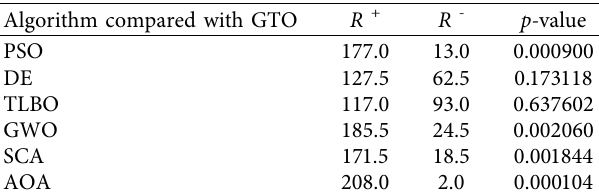
Table 11: Wilcoxon signed rank test for the pairwise comparison between GTO and its peer